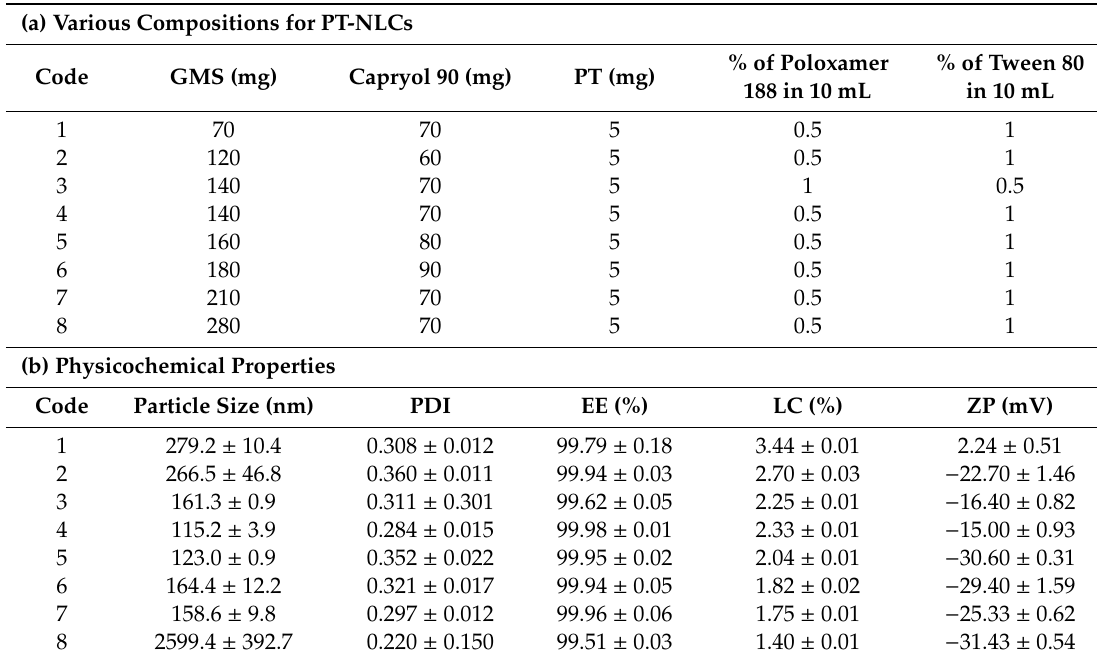
Table 1. Various compositions for PT-NLCs (a) and their physicochemical properties (b) ( n = 3). (a) Various Compositions for PT-NLCs Code